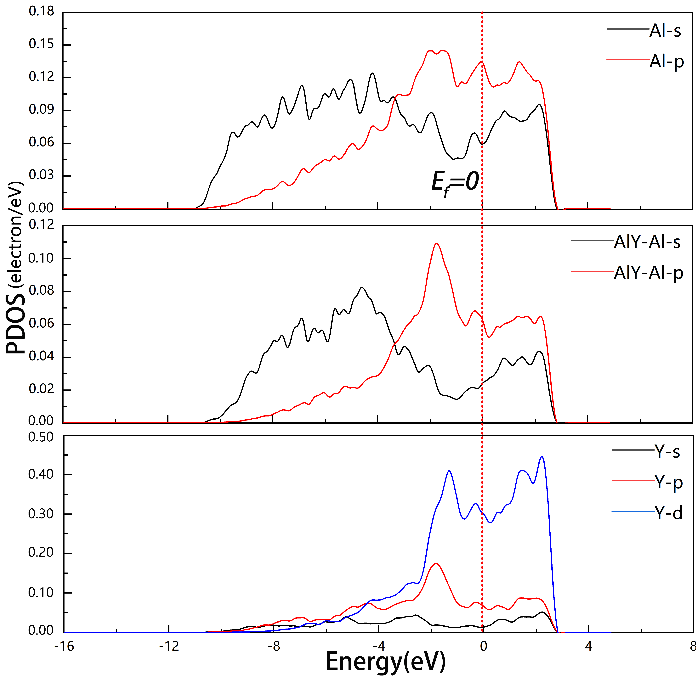
Figure 8. PDOS of Model2 of Al 3 Y(111)|Al(111) interface.